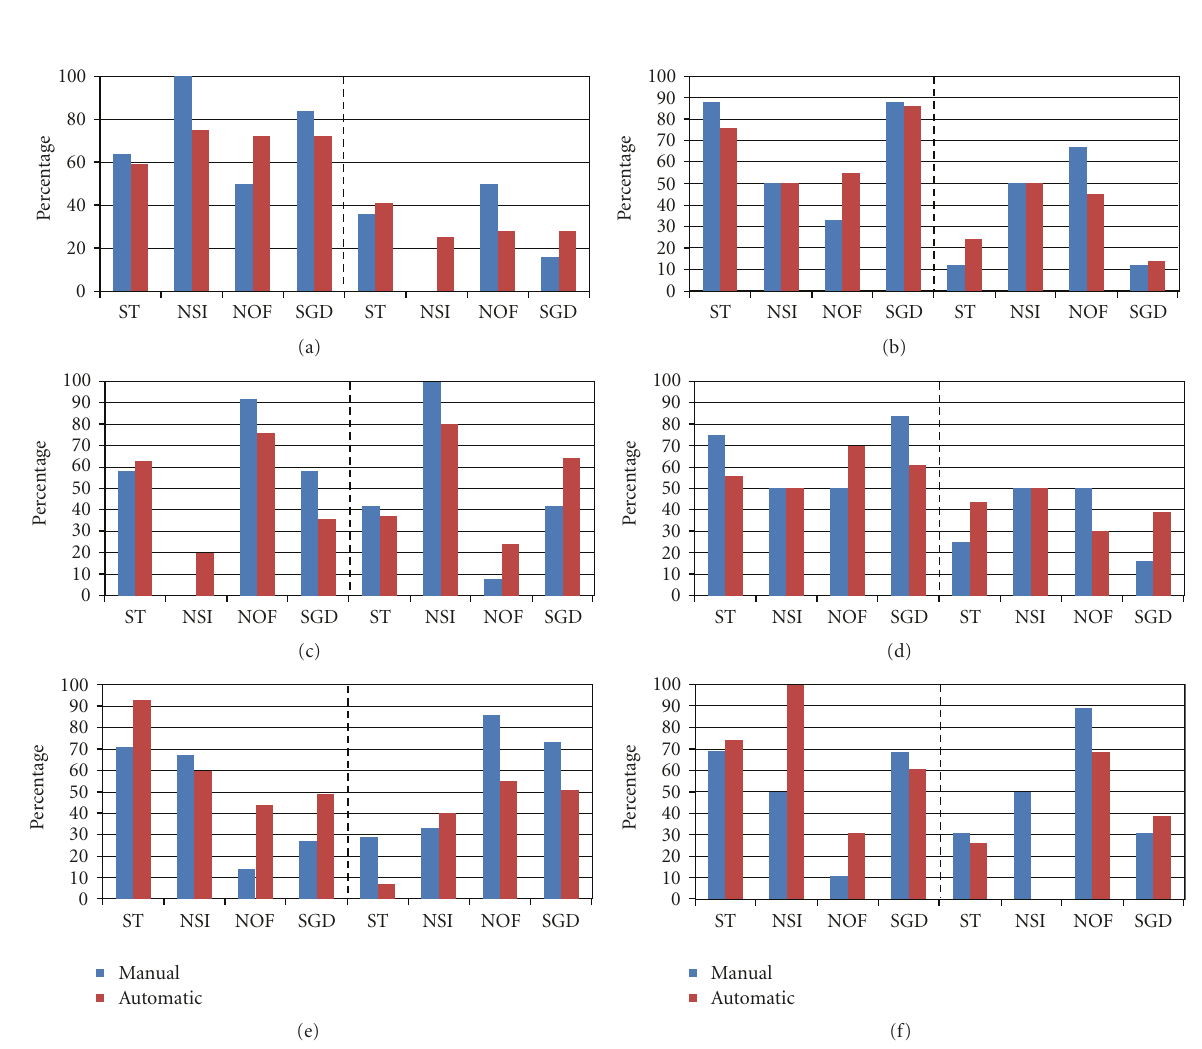
Figure 7: Manual (blue) and automatic (red) dominance indicators values.